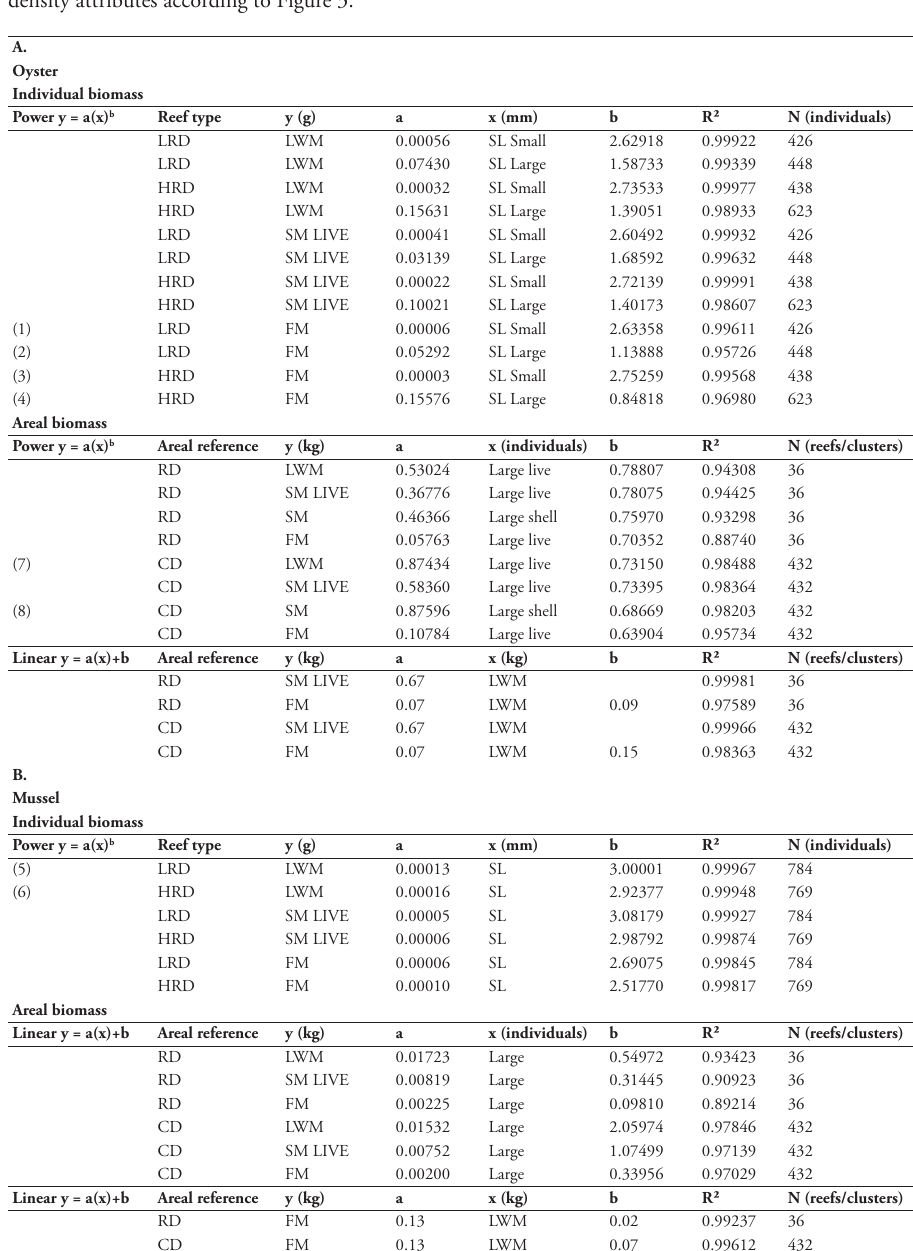
Table 2. Oyster and mussel scaling parameters (a, b) of powered or linear relationships between indi- vidual metrics or density attributes. Allometric scaling (1–4) displayed in Figure 5A and (5, 6) in Figure 8B. Density scaling (7) displayed in Figure 14A and (8) in Figure 14B. R² = coefficient of determination. N = number of basic data points. Reef type determination according to Figure 4C. Density metrics and density attributes according to Figure